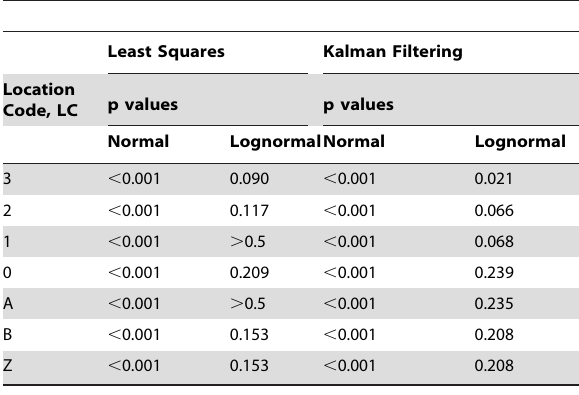
Table 3. Fits of position errors to normal and lognormal